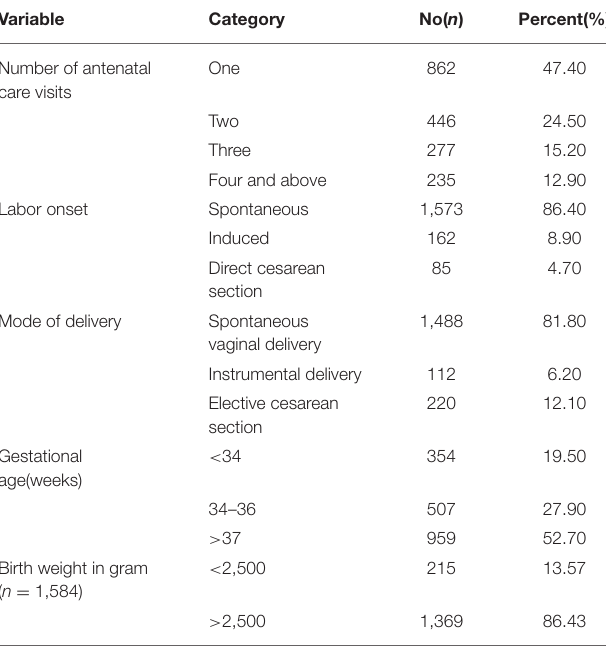
TABLE 2 | Pregnancy induced hypertension and related characteristics of perinatal mortality among mothers who attended ANC at Gamo Zone, Southern Ethiopia,